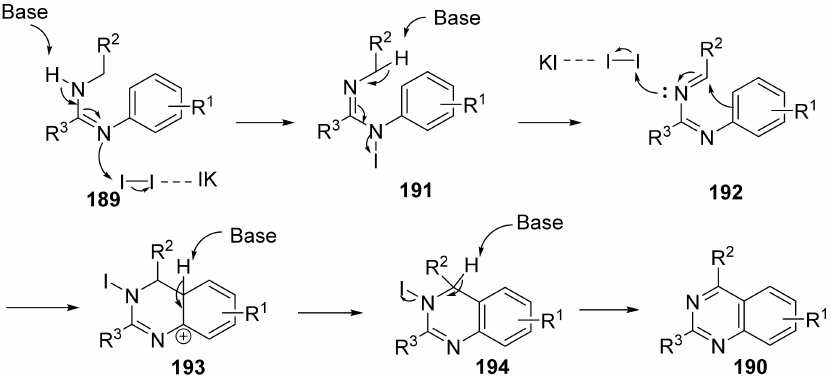
Scheme 54. Reaction mechanism of cyclization to